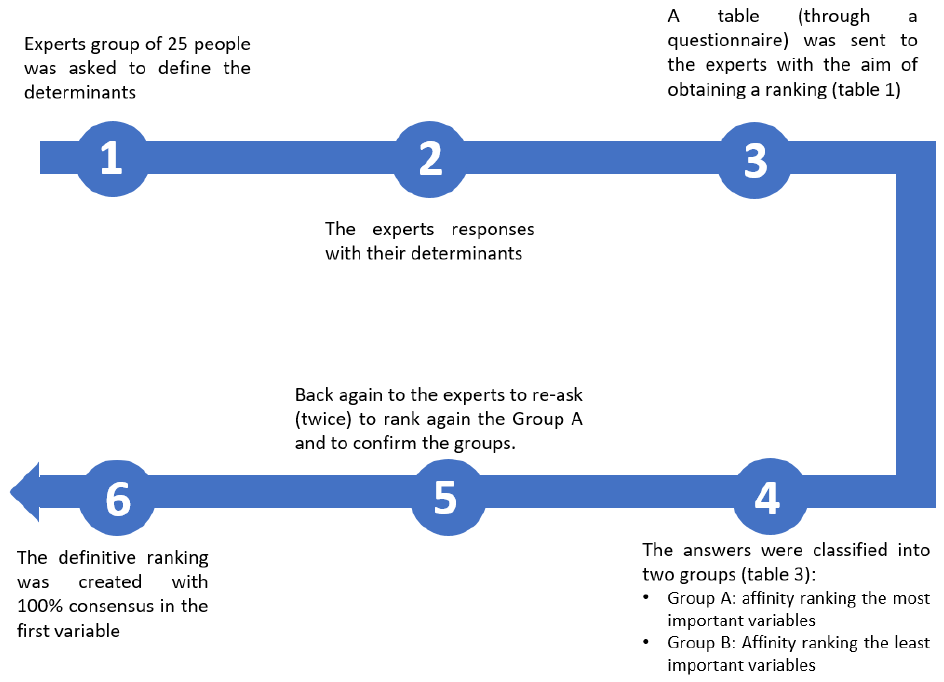
Figure 2. Delphi method description along with its six